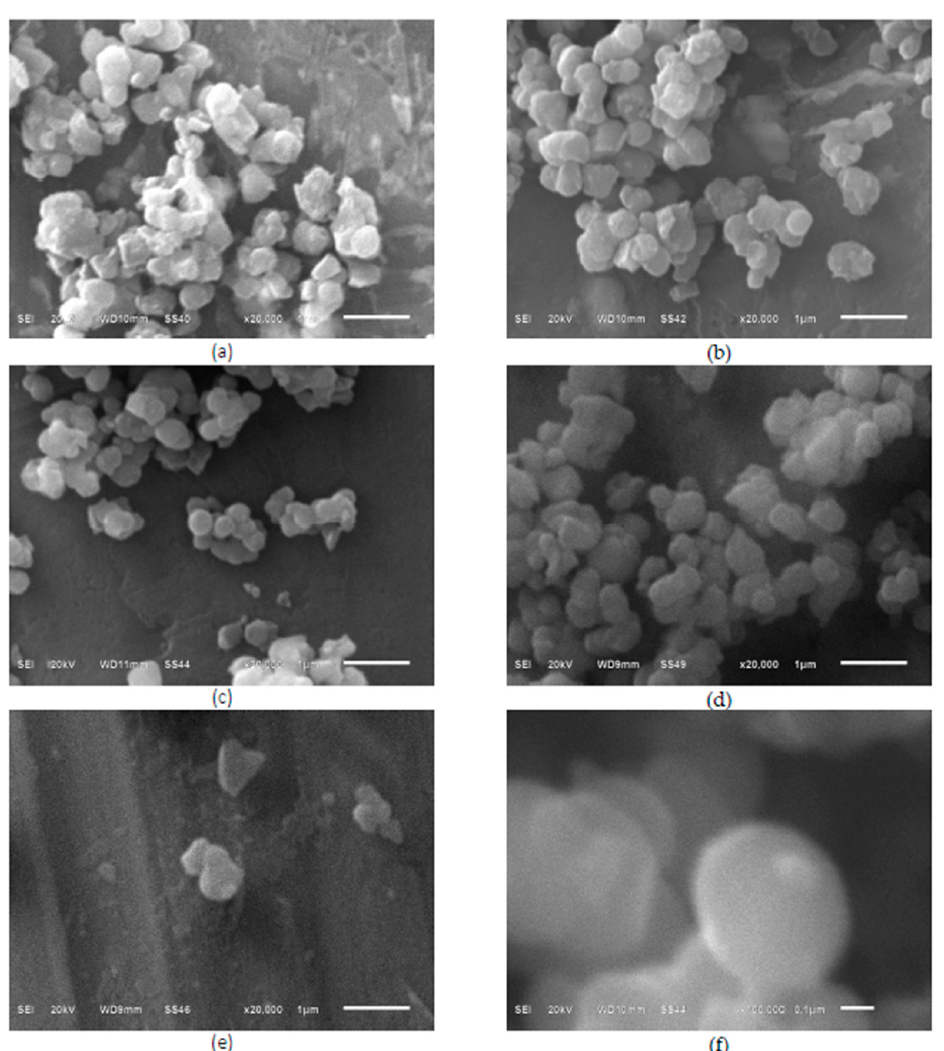
Figure 2. Scanning electron microscope (SEM) micrographs of all the CD-aTiO 2 prepared ( a ) DTIB-01; ( b ) DTIB-02; ( c ) DTIB-03; ( d ) DTIB-04; ( e ) DTIB-05; ( f ) the disc morphology with a dimension of ~300 nm in diameter of these products can be observed in the last pictured.